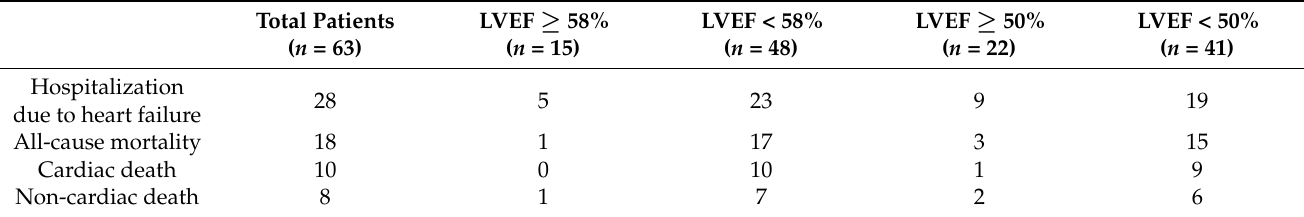
Table 5. The number of patients who reached the study